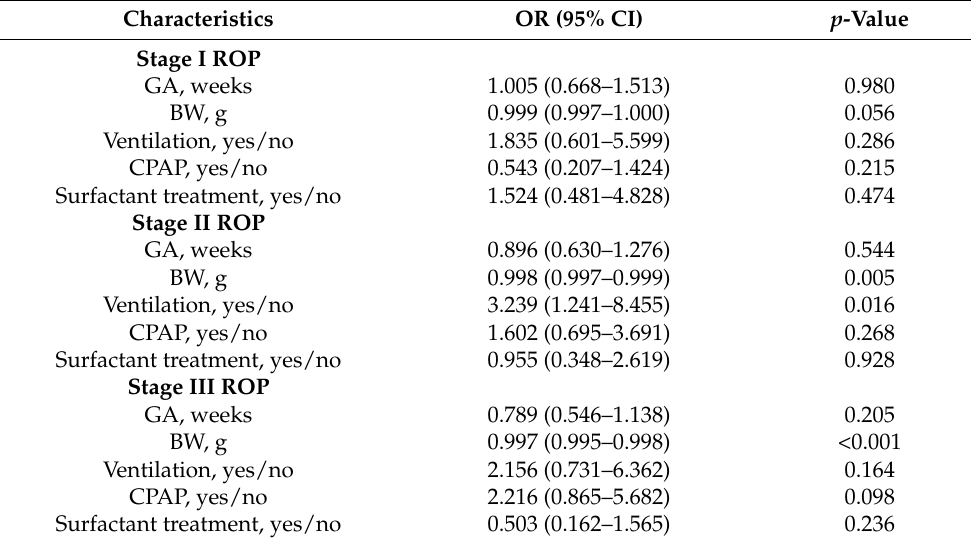
Table 5. Comparisons between infants with an absence of ROP in all stages and those with Stage 1, 2, and 3 ROP. In this model, only BW was a significant predictor of Stage 3 ROP ( p < 0.001), while both ventilation and BW were significant predictors of Stage 2 ROP ( p <